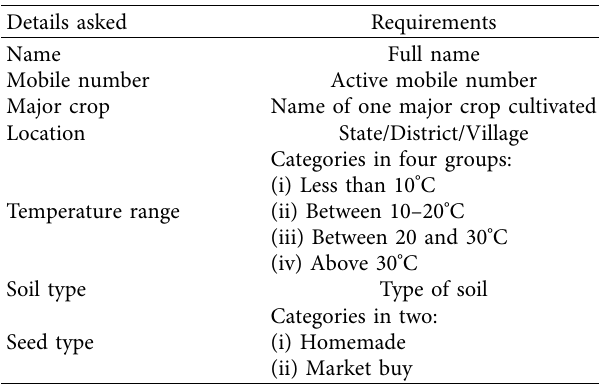
Table 1: Data survey form